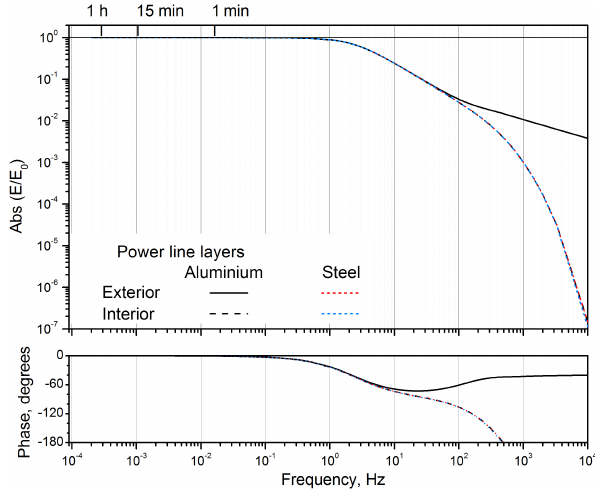
Figure 6. The frequency dependencies of normalized absolute am- plitude (top) and phase (bottom) of the electric field at the outer and inner surfaces of the aluminium (black lines) and steel (red and blue lines) in transmission line wire, located in air with conductivity 10 − 14 Sm − 1